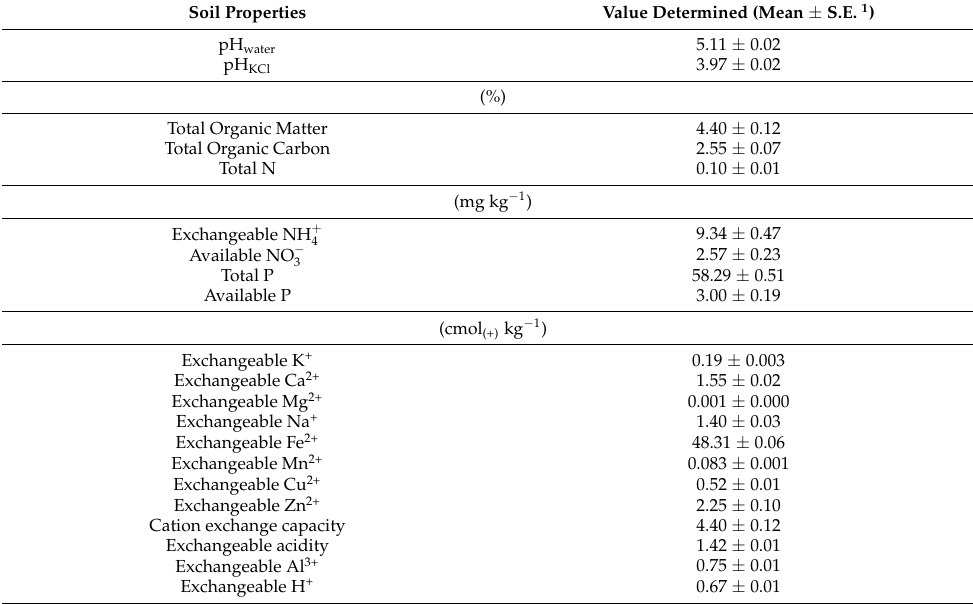
Table 4. Initial chemical properties of Nyalau series ( Typic Paleudults